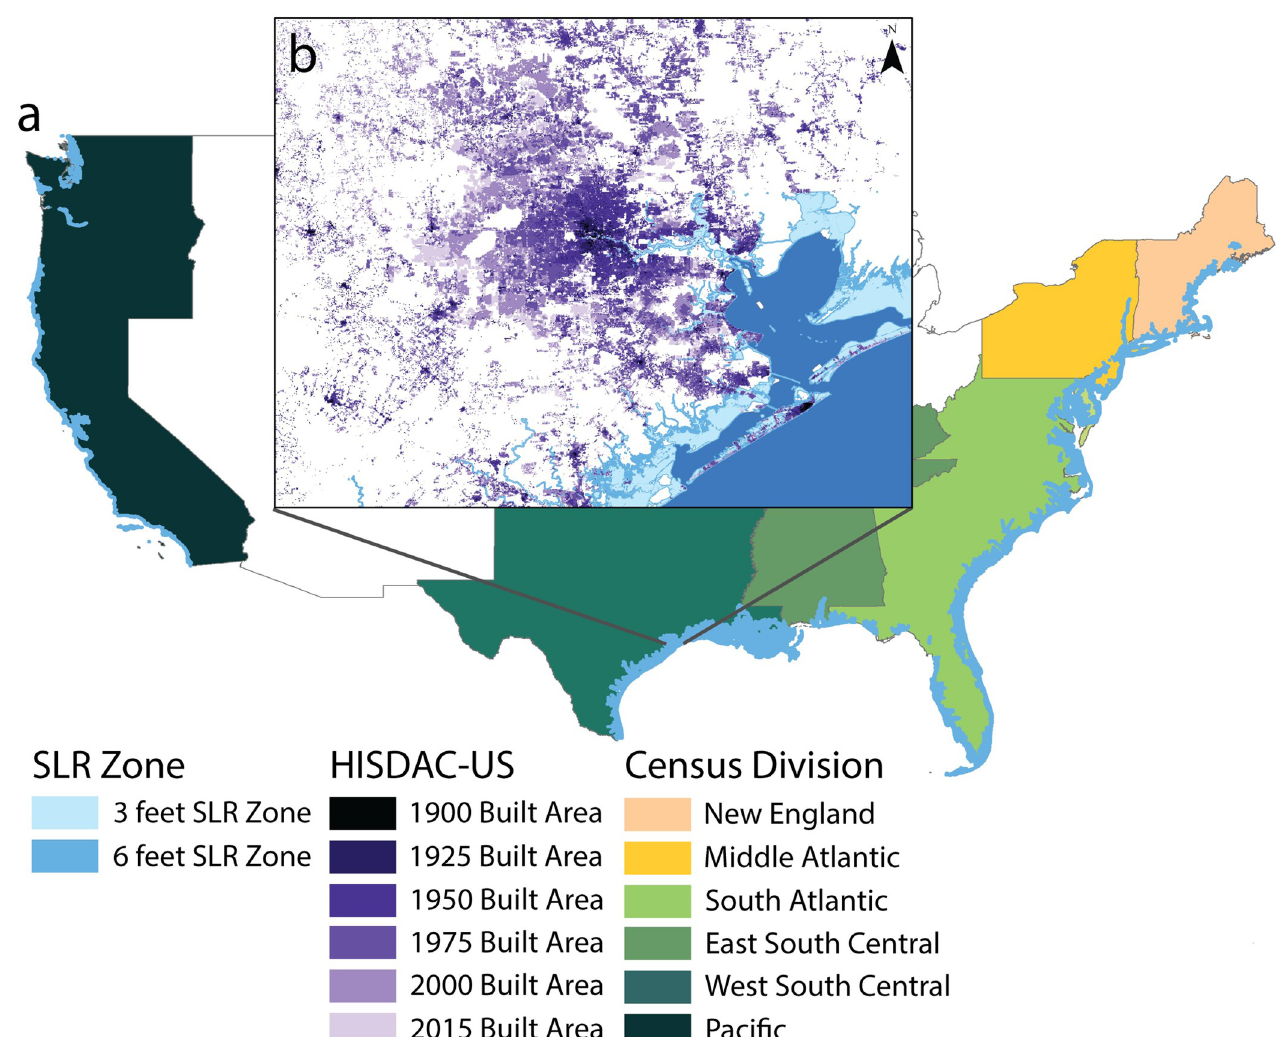
Fig 1. This analysis covers sea level rise zones (3 feet / 0.91 meters and 6 feet / 1.83 meters) across the conterminous United States [33] and by Census Division [34], with the 6 feet SLR zones displayed in blue (a). The spatial distribution of the year the first structure was built, provided by the HISDAC-US database [22], illustrates the historical development of cities, such as Houston, displayed in the inset (b). All data used in figure available through an open license for U.S. government datasets [33, 34] or through a CC0 license